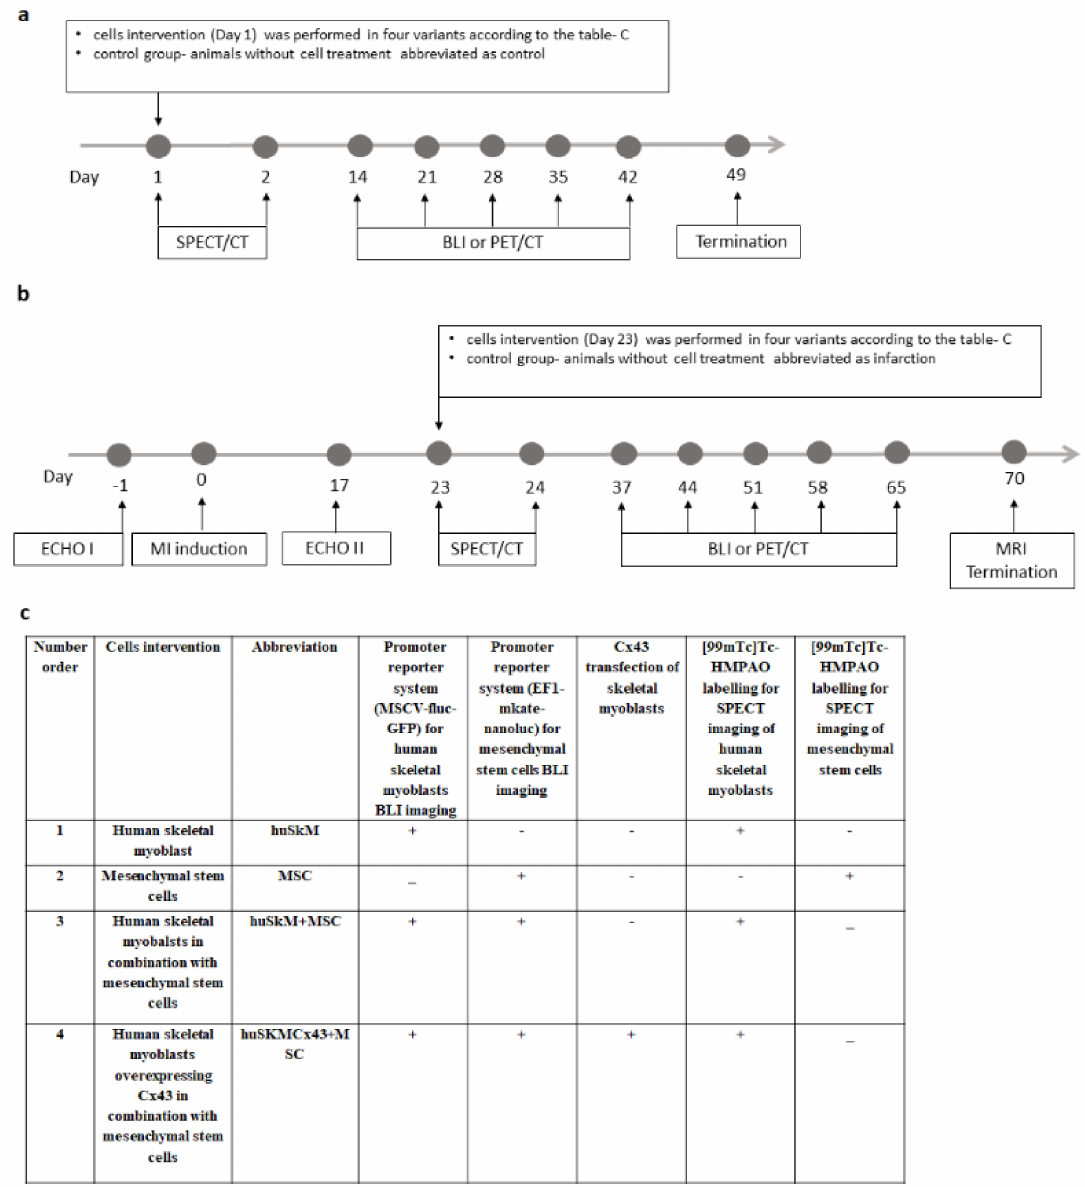
Figure 1. Scheme of experimental design of in vivo animal experiments. ( a ). Procedure 1 was performed in NOD/SCID mice with the healthy heart. On day 0, immunocompromised mice were divided into 4 subgroups based on the cell intervention. Four different combinations of cells were transplanted into the healthy mouse heart at day 1. 1. huSkM- human skeletal myoblasts, 2. MSC- mesenchymal stem cells 3. huSkM + MSC- human skeletal myoblasts in combination with mesenchymal stem cells, 4. huSkMCx43+MSC- human skeletal myoblasts overexpressing Cx43 in combination with mesenchymal stem cells. SPECT/CT was performed immediately after the transplantation and 24 h later Then, the biodistribution of transplanted cells was observed using a bioluminescent imaging system (BLI) for 6 weeks (day 14,21,28,35,42). On day 49, the animals were terminated. ( b ). According to Procedure 2, initial control echocardiography (ECHO I) was performed prior to the in vivo experimental series, and myocardial infarction (MI) was induced by left coronary artery ligation on day 0. Seventeen days later, a second echocardiography (ECHO II) confirming successful MI induction was performed. On day 23, cell intervention was performed in the same four combinations as described for Procedure 1. SPECT/CT was performed immediately after the transplantation and 24 h later. The retention of the cells in the myocardium was observed using a BLI system up to 10 weeks (day 37, 44,51,58,65). On day 70, MRI imaging was performed, and the animals were terminated. Untreated animals (infarction) were used as the controls, and PET/CT and MRI were performed in this group for comparison. ( c ). Table indicates stem cells modifications that were introduced prior to their in vivo transplantation.